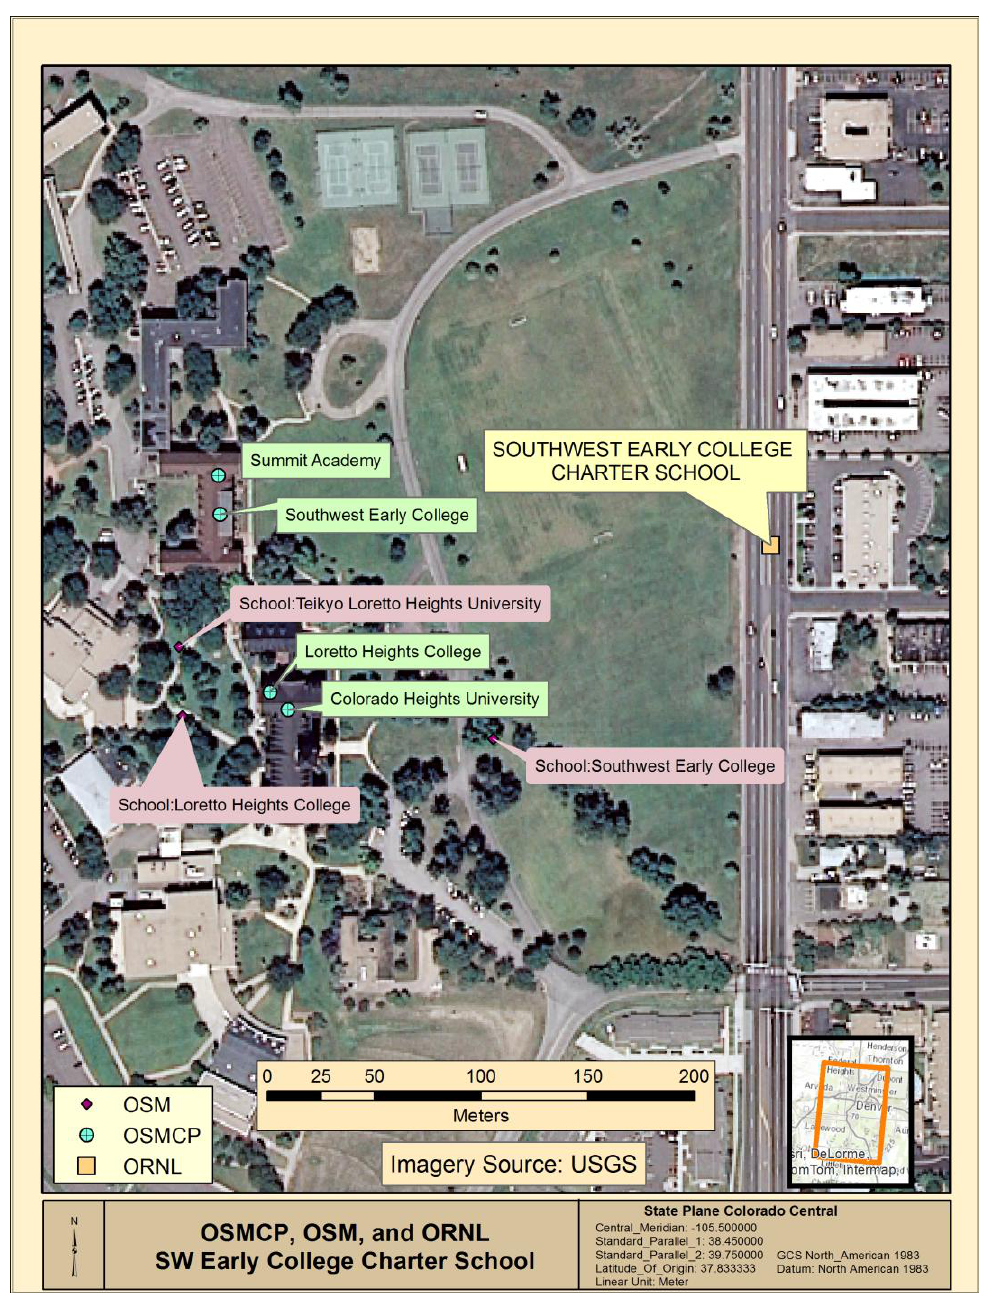
Figure 3. Various identified locations of Southwest Early